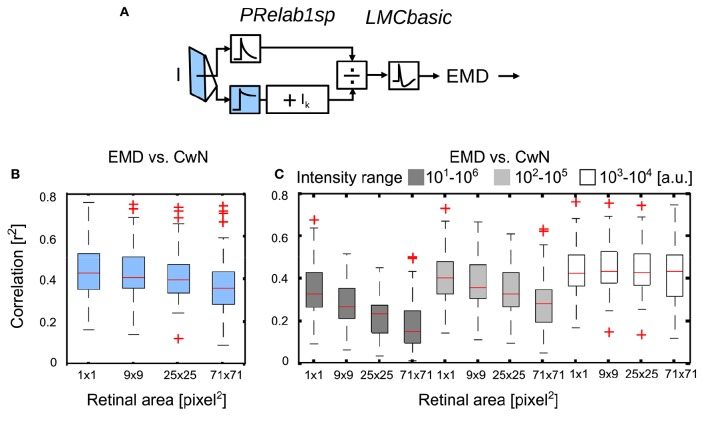
Effect of the retinal area of brightness adaptation of photoreceptor on spatial vision. (A) Variant of visual motion pathway model PRelab1sp-LMCbasic-EMD (see Figure 2 and Appendix A). Signal input to the lower branch of the adaptive PR model (blue), which reflects the current light level used for adaptation, was spatially pooled with 2D spatial Gaussian filter with different half-widths (1 × 1, 9 × 9, 25 × 25, 71 × 71 pixel2, with each pixel corresponding to 1.25° of the visual field). (B) Correlation between response profile of EMDs and CwN under various retinal areas of adaptation. (C) The same as (B), only the range of input intensity was artificially rescaled (Equation 7) to cover five decades (black), three decades (gray), one decade (white), respectively (intensity values in arbitrary units).